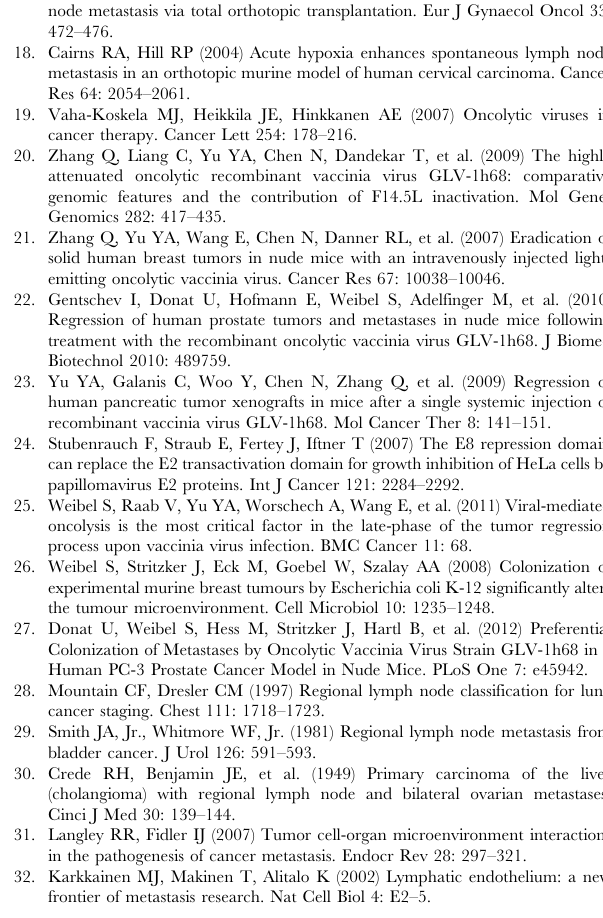
Table S1 HPV-status of different cervical cancer cell lines and their response to oncolytic vaccinia virus therapy. Different cervical cancer cell lines were screened for the effects of oncolytic virus therapy with GLV-1h68. The plus ( + ) in the second column indicates the presence of HPV DNA in cancer cells, minus (-) the absence. Plus in the last column means a successful regression of the tumor after virus administration, while minus in this column indicates that virus administration had no effects on tumor